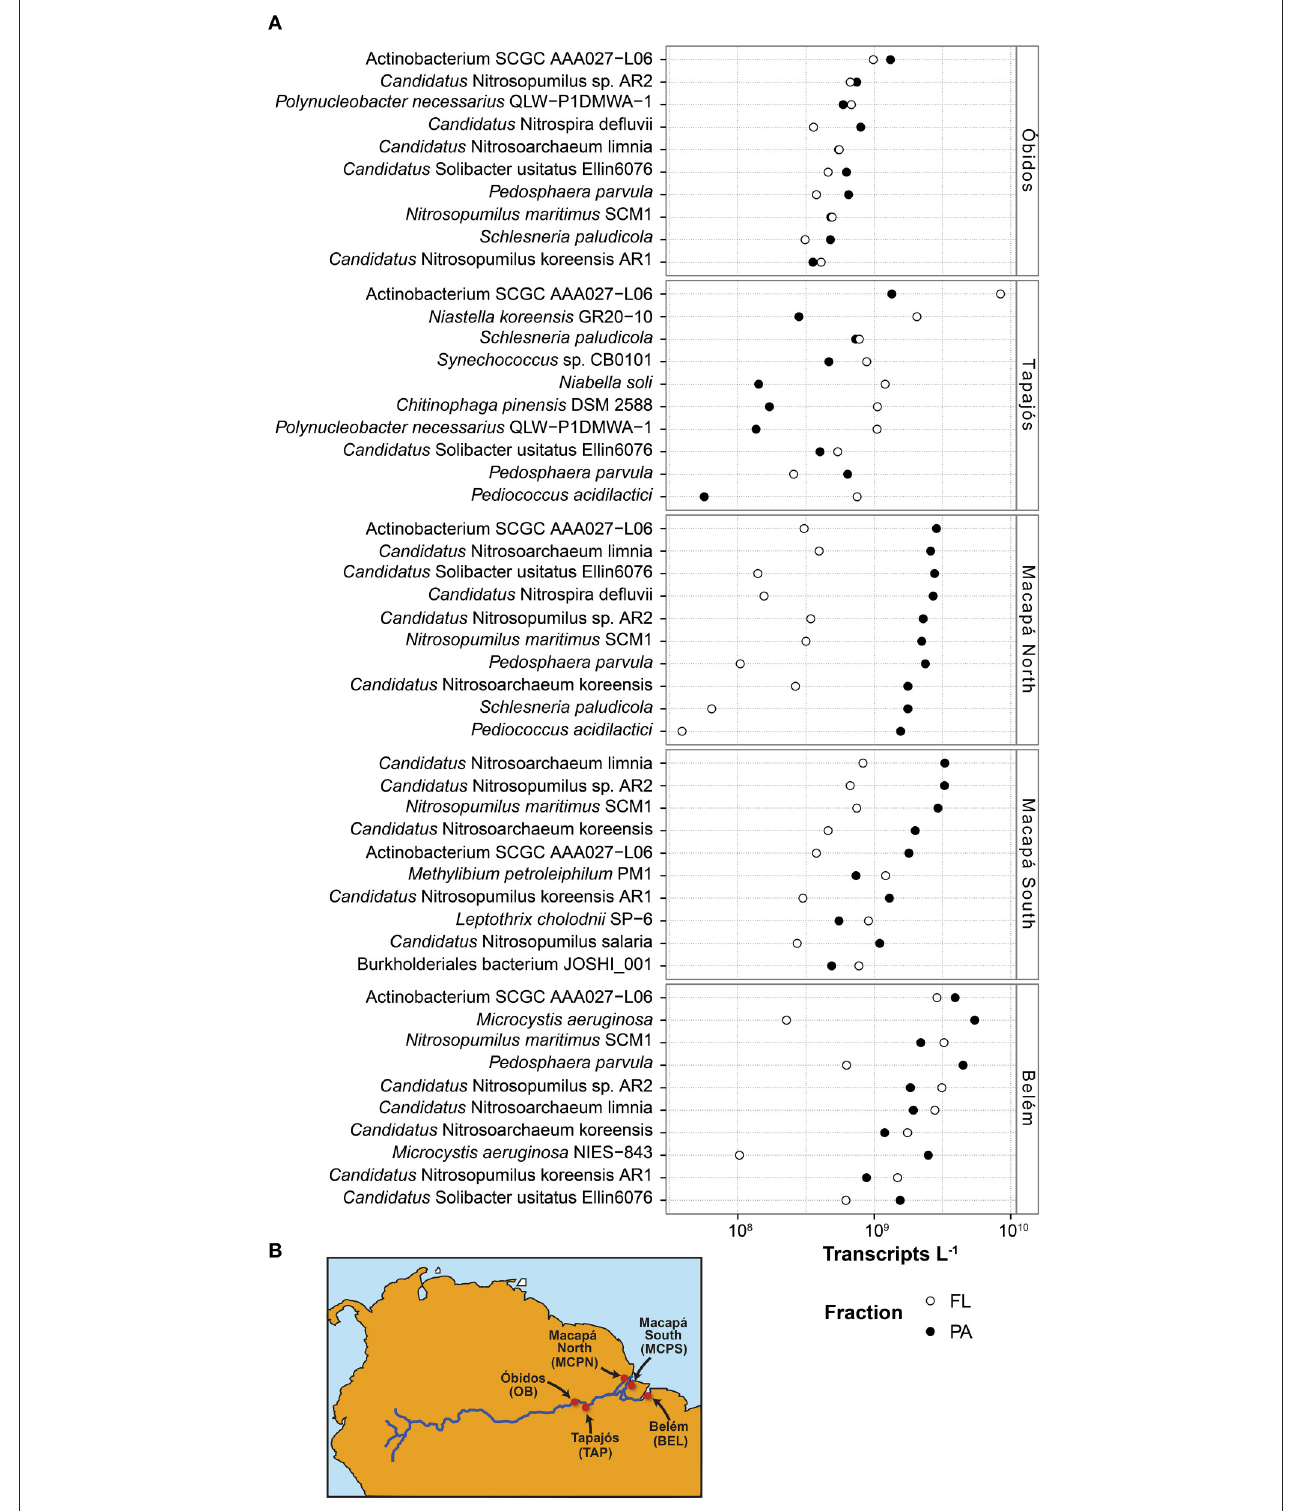
FIGURE 1 | (A) Transcript inventories (transcripts L − 1 ) for the ten most transcriptionally abundant bacterial and archaeal taxonomic bins at five river stations in May 2011. Circle fill indicates the microenvironment (free-living, open; particle-associated, closed). (B) Station locations in the lower Amazon River.